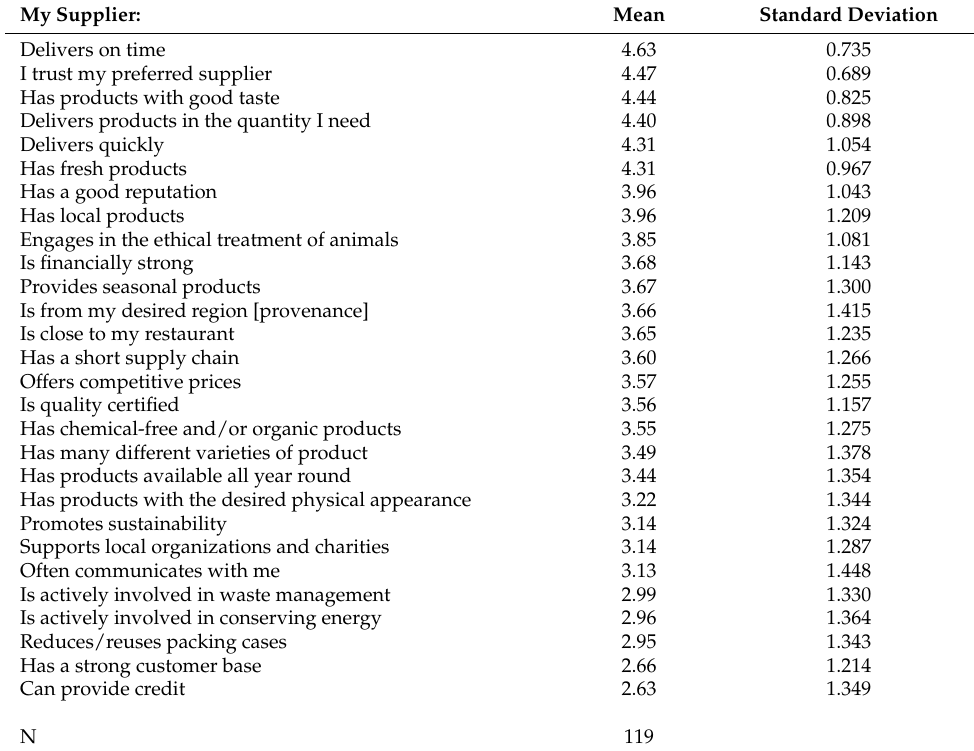
Table 1. Importance of supplier purchasing